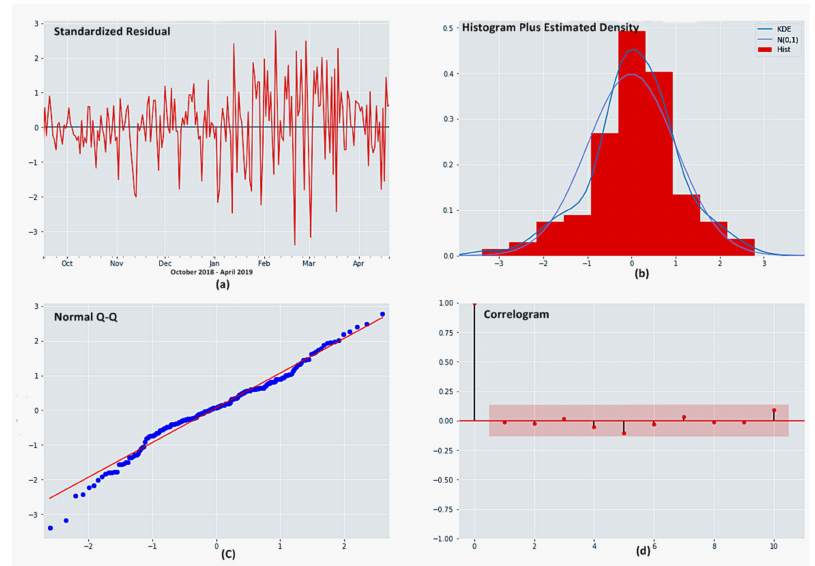
Figure 4. Visualizations plotted using 6 months of data from 1 year of real-time data of MWh through machine learning. ( a ) Difference between observed and expected values of MWh. ( b ) MWh data values into the specified range. ( c ) Distribution for a random variable in the given MWh data. ( d ) Illustration of the randomness in the MWh data.